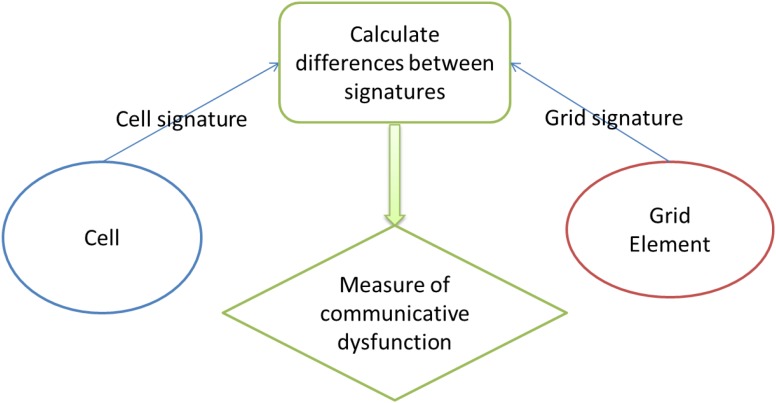
Handshake protocol.